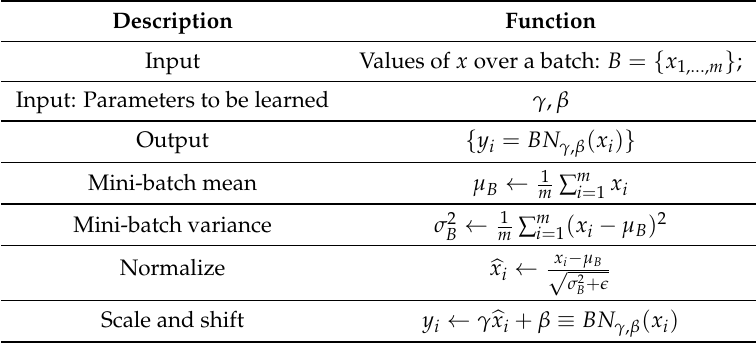
Table 1. Applying the batch normalizing layer on a given batch of